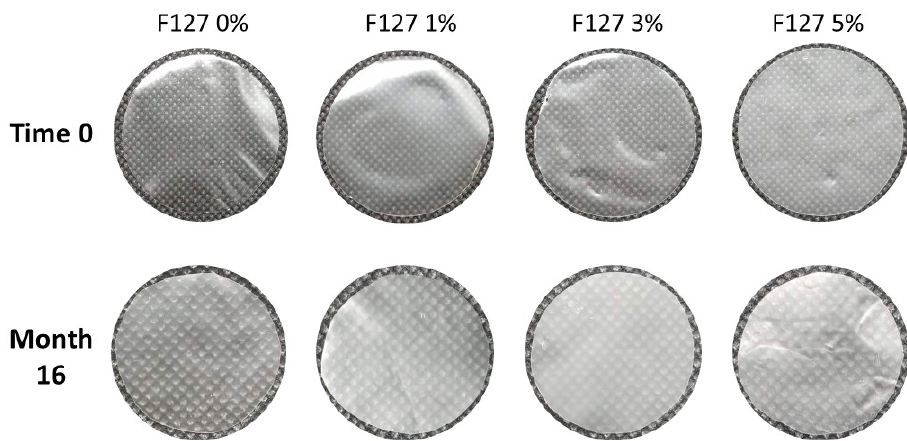
Figure 1. Biodegradable films based on corn starch and chitosan with pluronic F127 at 0%, 1%, 3%, and 5%; images were captured in the initial storage time (time 0) and after 16 months of storage at room temperature; the photos of the films at 16 months were taken at higher magnification. Table 1. Effect of poloxamer content and storage time on water solubility, color, contact angle, and mechanical properties of corn starch-chitosan biodegradable films.